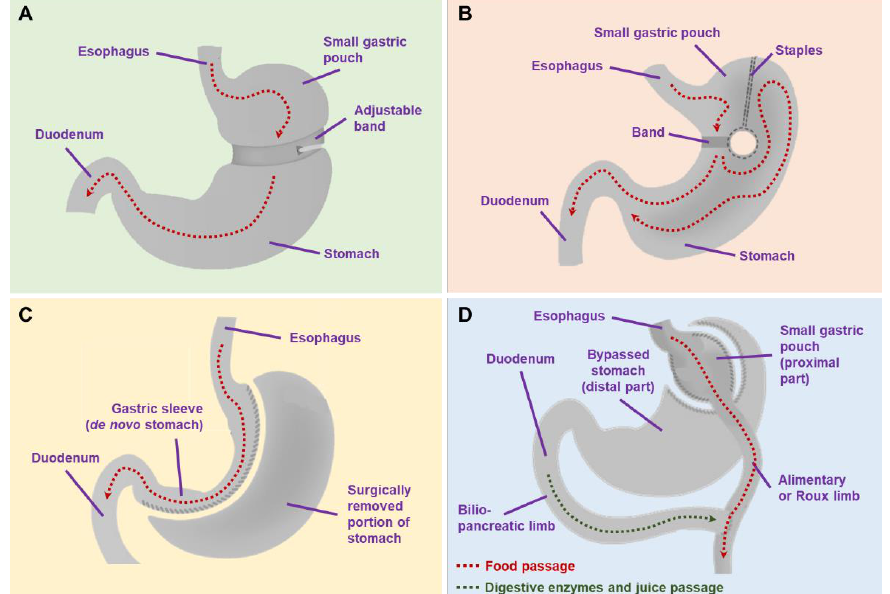
Figure 1. Commonly performed bariatric surgery procedures: ( A ) gastric banding; ( B ) vertical banded gastroplasty; ( C ) sleeve gastrectomy; ( D ) Roux-en-Y gastric bypass.